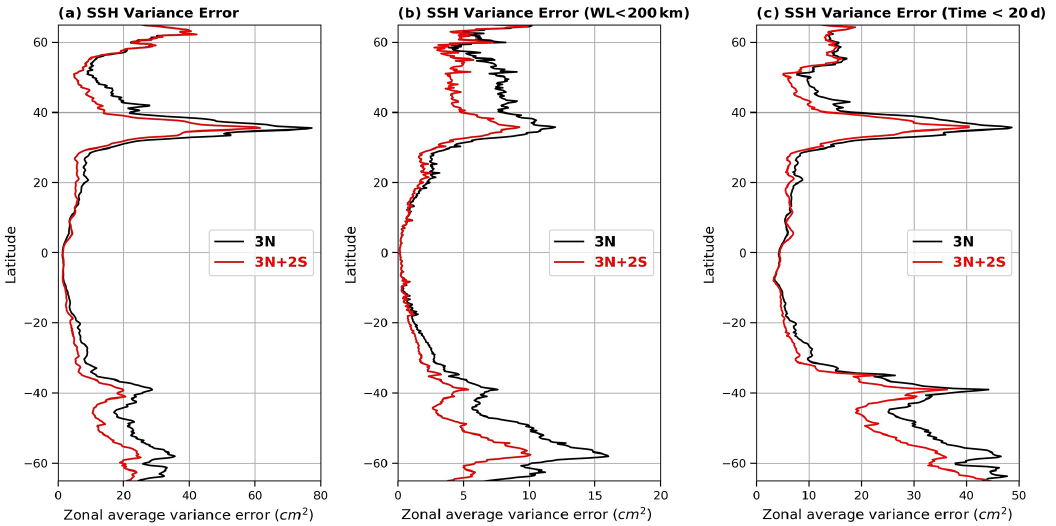
Figure 9. The zonal SSH averaged error variance: (a) for full scales, (b) for scales less than 200km and (c) for timescales less than 20d; assimilation of 3N (black lines) and assimilation of 3N + 2S (red lines). Units are cm 2 .